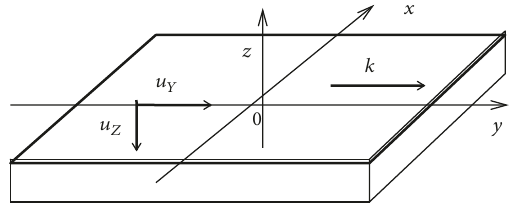
Figure 1: The coordinate system of the question of the wave propagation along the 𝑧